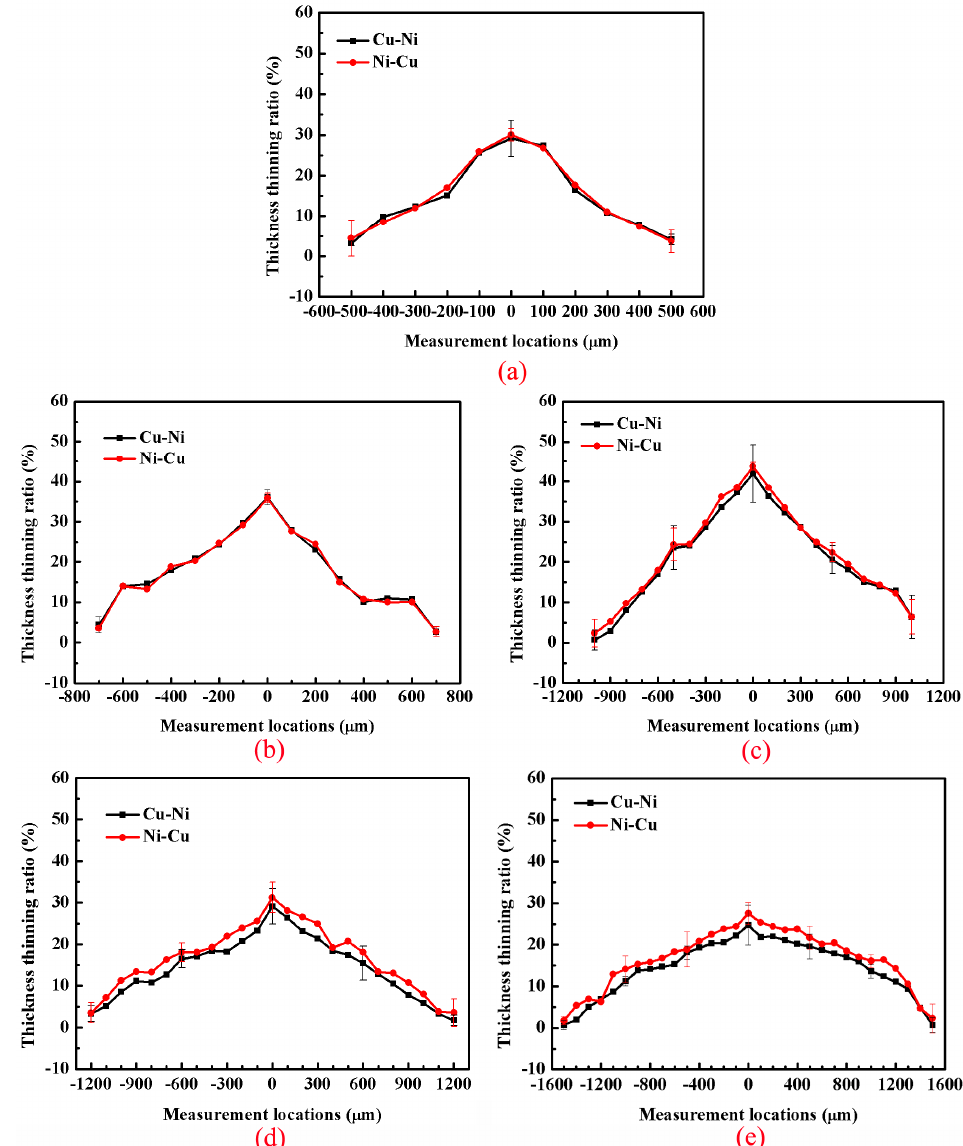
Figure 8. Thickness thinning ratio of entire sheet: ( a ) mold 1; ( b ) mold 2; ( c ) mold 3; ( d ) mold 4; ( e ) mold 5.